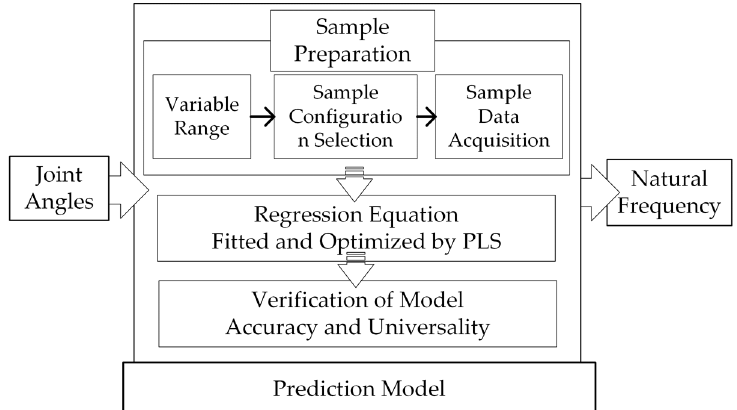
Figure 2. Prediction method of robot natural frequency.